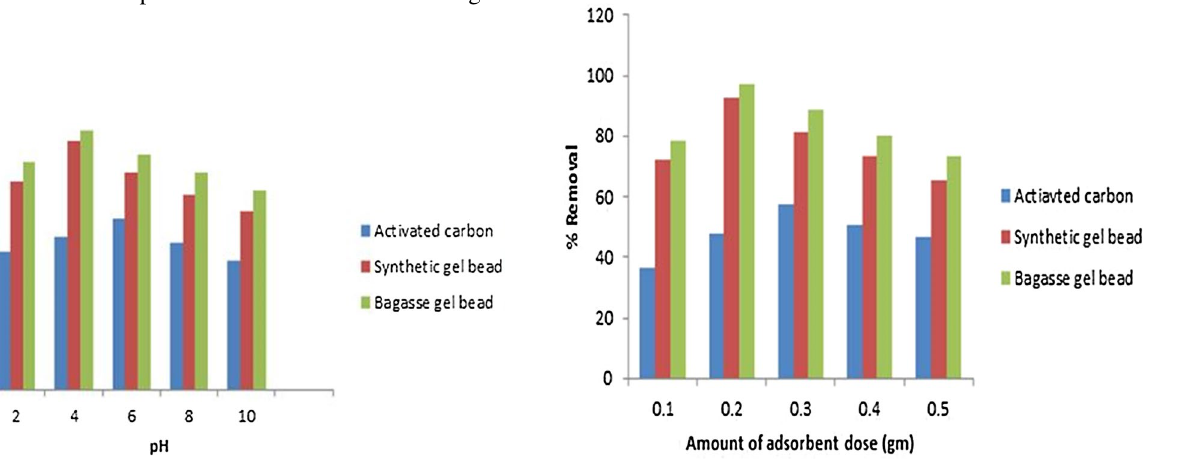
Fig. 2 Effect of pH on the adsorption of chromium ions onto bio- polymer beads and activated carbon = 0.2, 0.3 g, pH = 4.6, tempera- ture = 25 °C